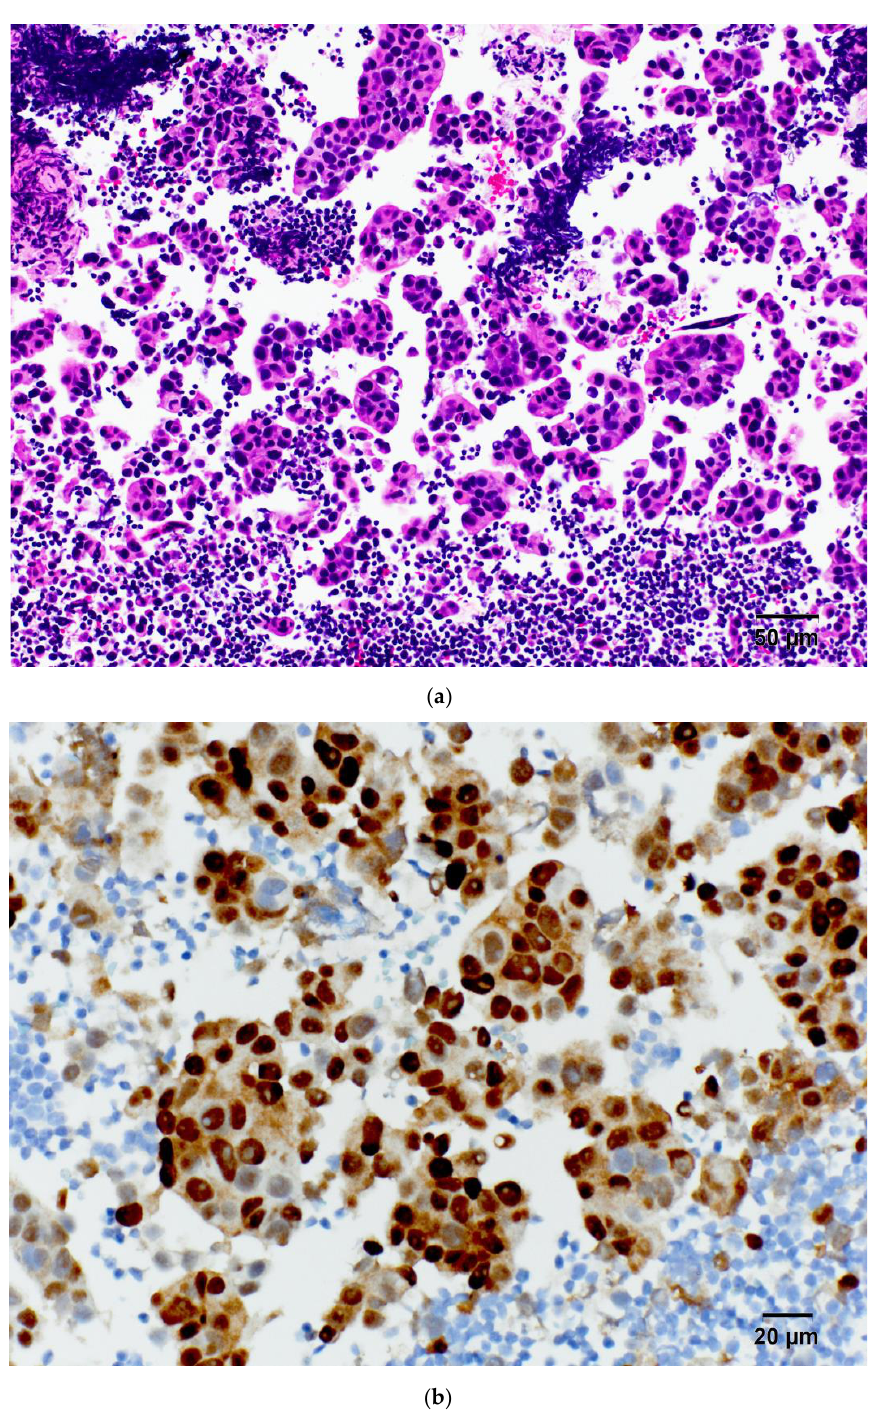
Figure 4. ( a ) Cytology cell block of a supraclavicular lymph node fine-needle aspirate shows metastatic breast carcinoma, present in cords and groups of tumor cells against a background of lymphoid tissue (hematoxylin and eosin stain). ( b ) Cell block of supraclavicular lymph node aspirate